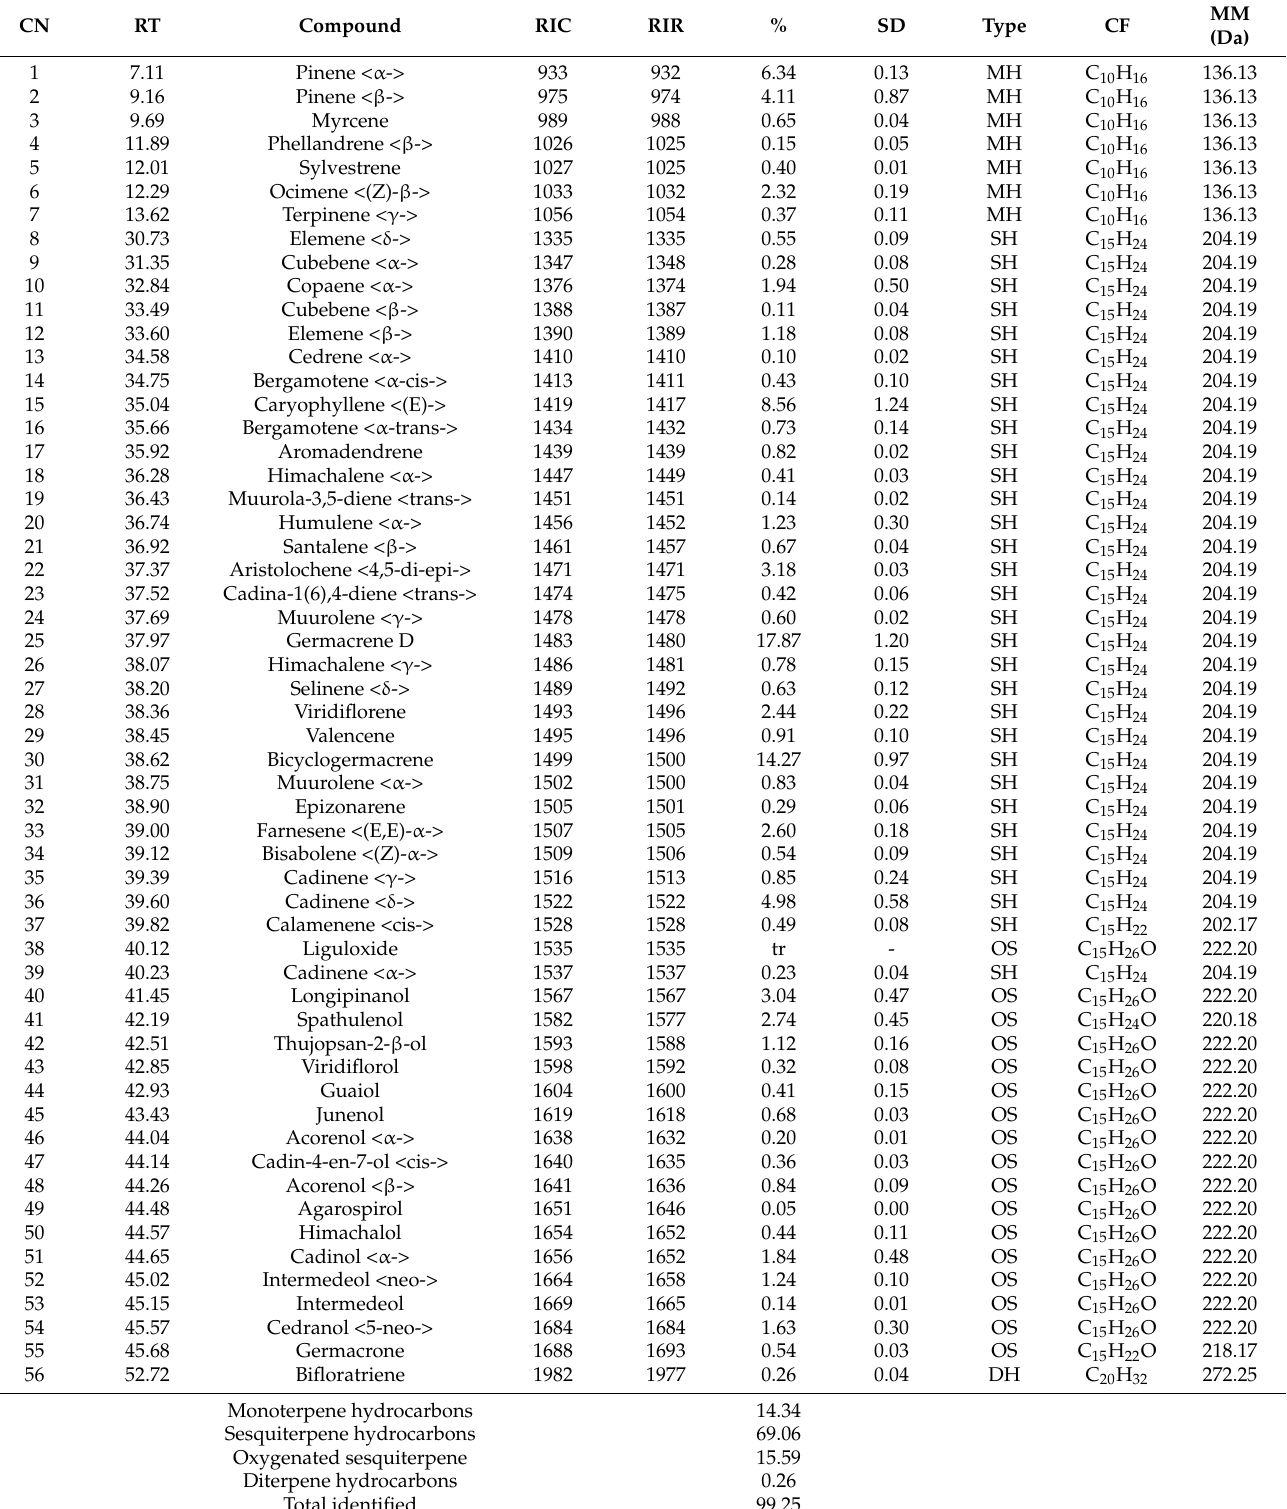
Table 2. Chemical composition of essential oil from the leaves of Bixa orellana